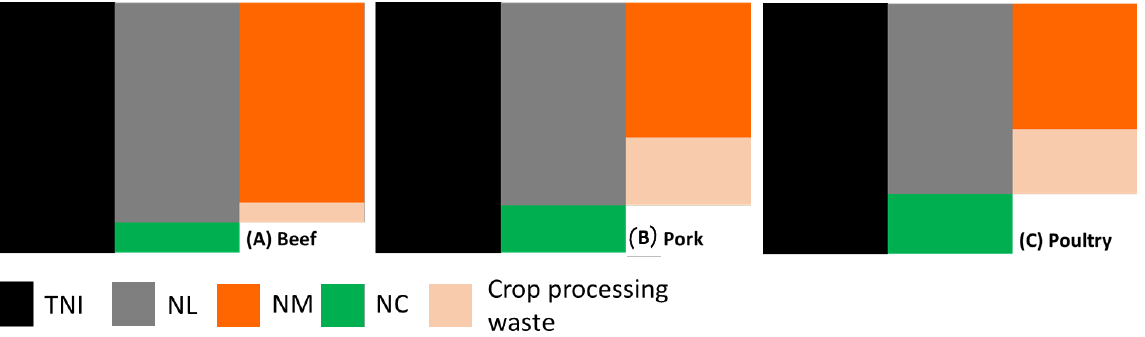
Figure 2. Tree diagram of nitrogen cycle per kg ( A ) beef, ( B ) pork and ( C ) poultry meat production, where TNI represents 100% in each case.